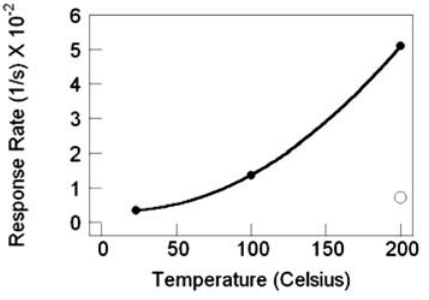
Figure 22. SnO nanowire sensor response rate versus temperature, filled circles are with 2 Pd catalyst, the nonfilled circle is without